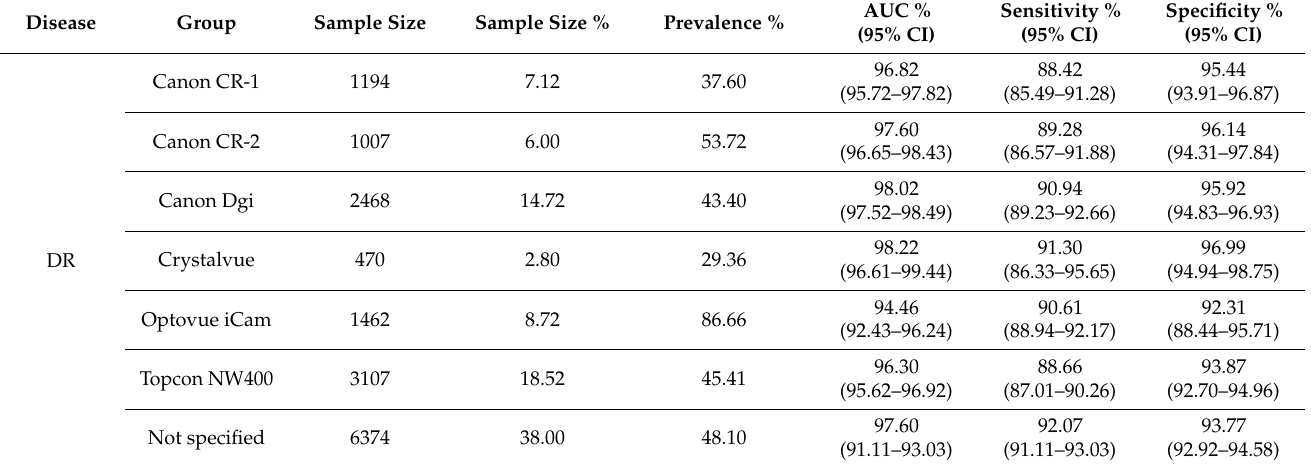
Table A6. Stratification results for the detection of referable retinopathy and diabetic macular edema on the patient level per camera